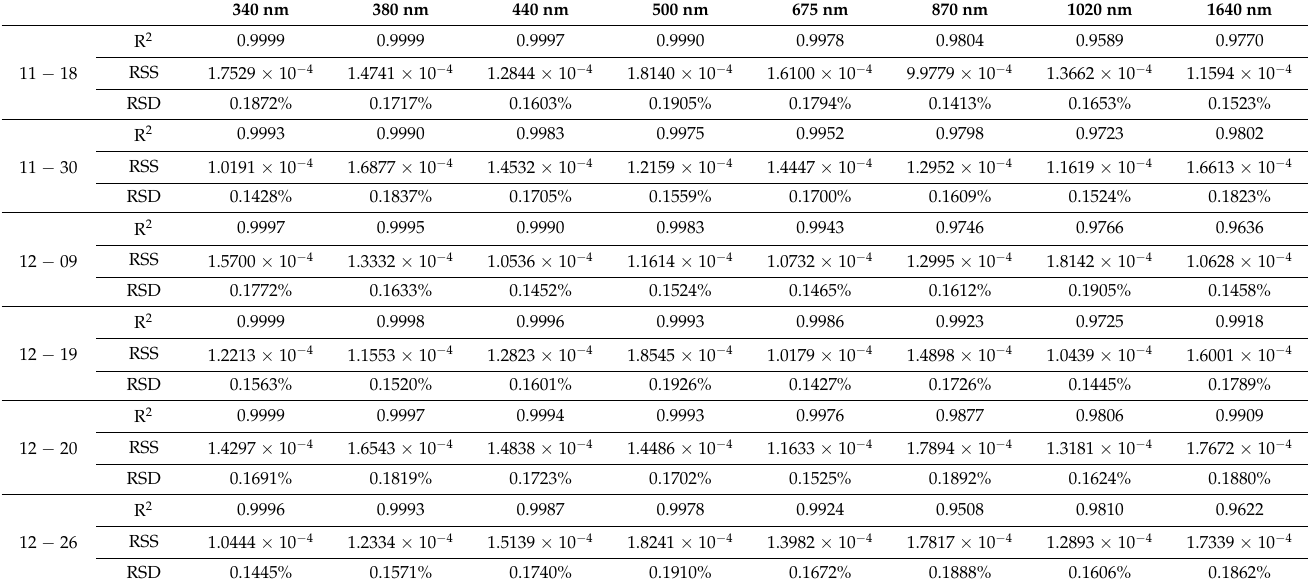
Table 3. Statistical analysis of the linear regression for Langley plots at the MFYD